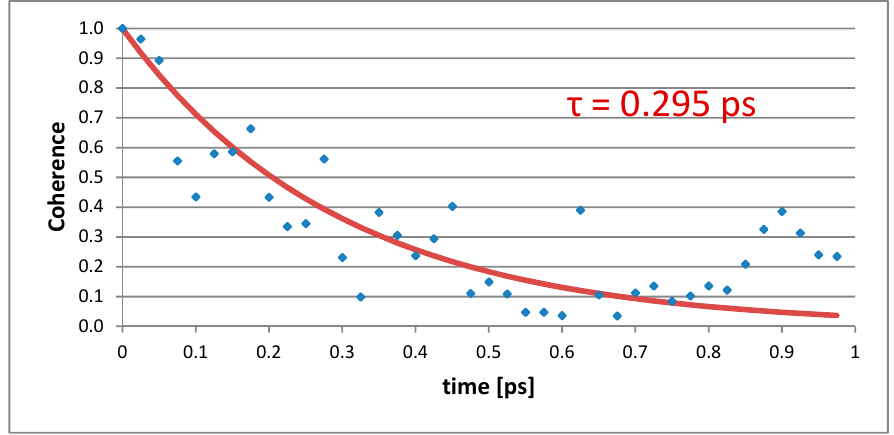
Figure 4. Example of decreasing coherence due to thermal perturbations. Results from a simulation are shown as blue crosses. The red line provides a least-squares fit of Equation (8) to the observations, giving a coherence time of 0.295 ps. A detailed explanation how coherence was calculated is given in Appendix A4.